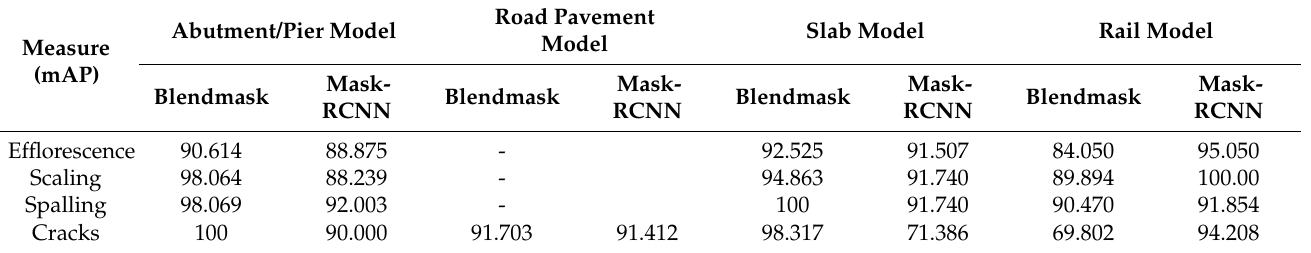
Table 9. Damaged-object-detection performance results of member specific models by damage